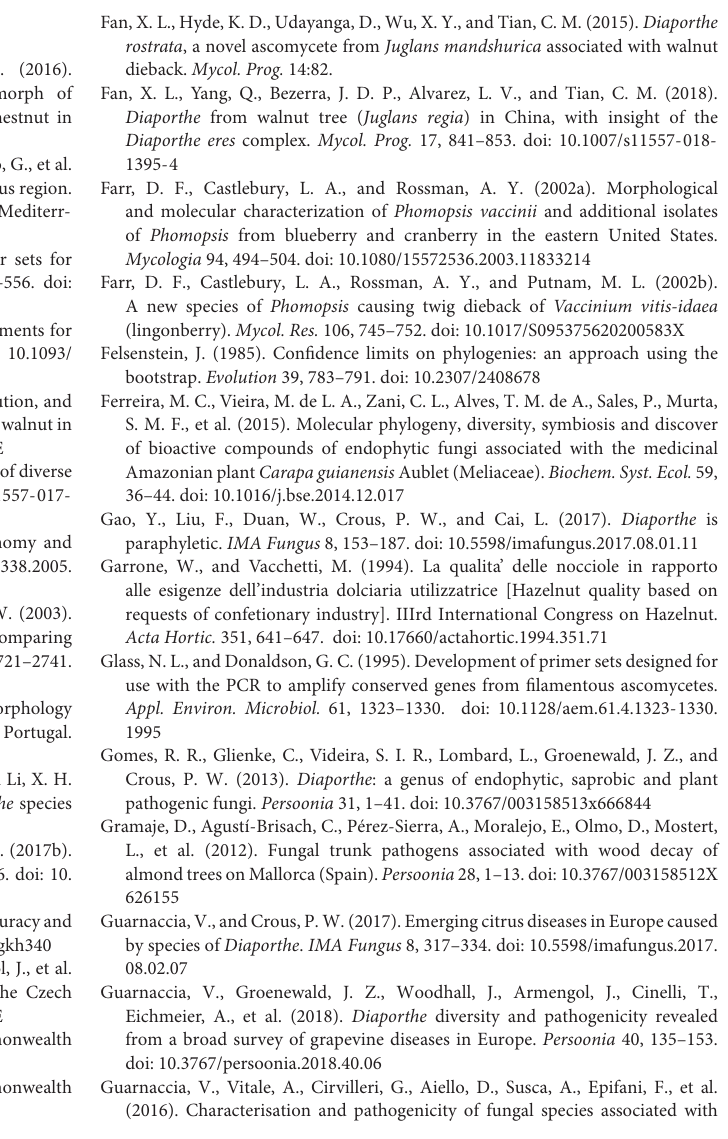
Supplementary Figure 2 | Tree branch topology representation of the tree presented in Figure 3 . Combined phylogeny for ITS, EF1- α , and tub sequence data of the 125 strains isolated from hazelnuts with other Diaporthe strains selected from the results presented in Supplementary Figure 1 and detailed in Supplementary Table 1 . Diaporthella corylina CBS 121124 T was used as the outgroup. Selected model: TN93 + G + I. The percentage of trees in which the associated taxa cluster together in the bootstrap test (1,000 replicates) is shown above the branches. Bold branches are supported with ≥ 0.95 Bayesian posterior probability. All positions with less than 95% site coverage were eliminated. The final dataset included 162 nucleotide sequences and a total of 981 positions. Supplementary Table 1 | List of strains used for the phylogenetic analyses with the corresponding ITS, EF1- α , and tub GenBank sequence accession numbers. The list includes a set of Diaporthe species selected from the literature and the 125 hazelnut strains amplified in this